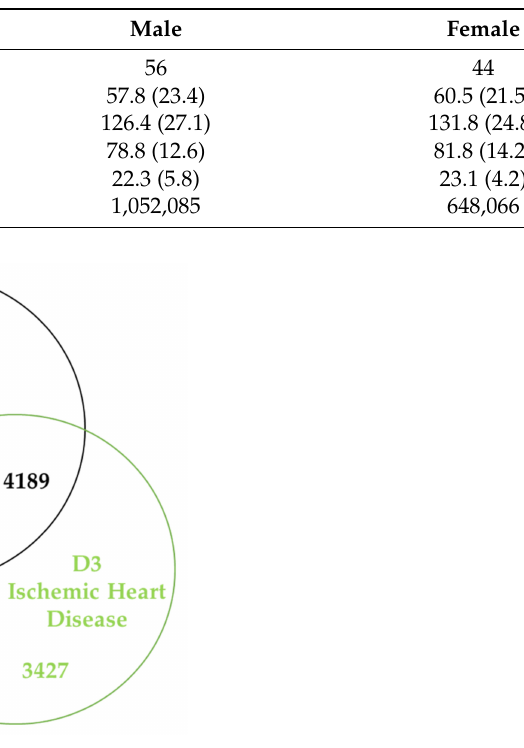
Figure 5. Population distribution of diabetes, cerebrovascular disease, and ischemic heart